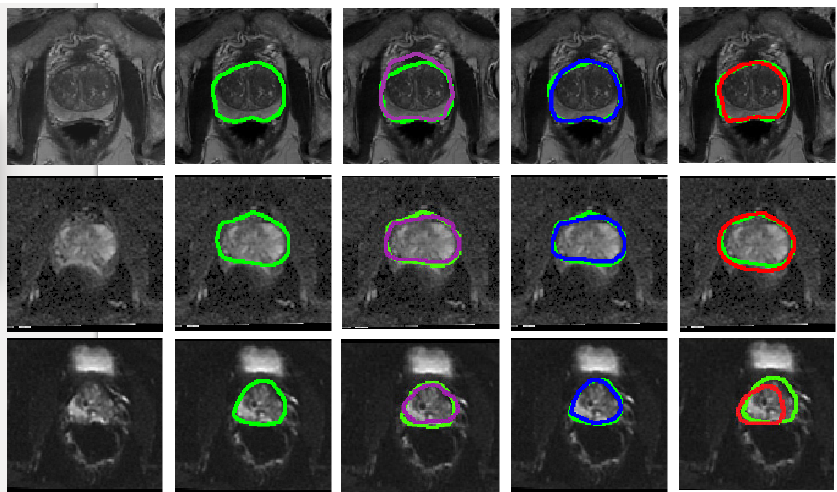
Figure A1. Visual representation of the predicted segmentation for each model and each modality for a single slice from a case study, where the prostate region is zoomed in and the image brightness is increased. From the top row to the bottom: T2W, ADC and DWI. From left to right: Raw test image, Ground truth boundaries in green, U-Net’s prediction in purple, cGAN’s prediction in blue and cycleGAN prediction in red. The quantitative results show the best performance for cGAN followed by U-Net for all evaluation metrics.